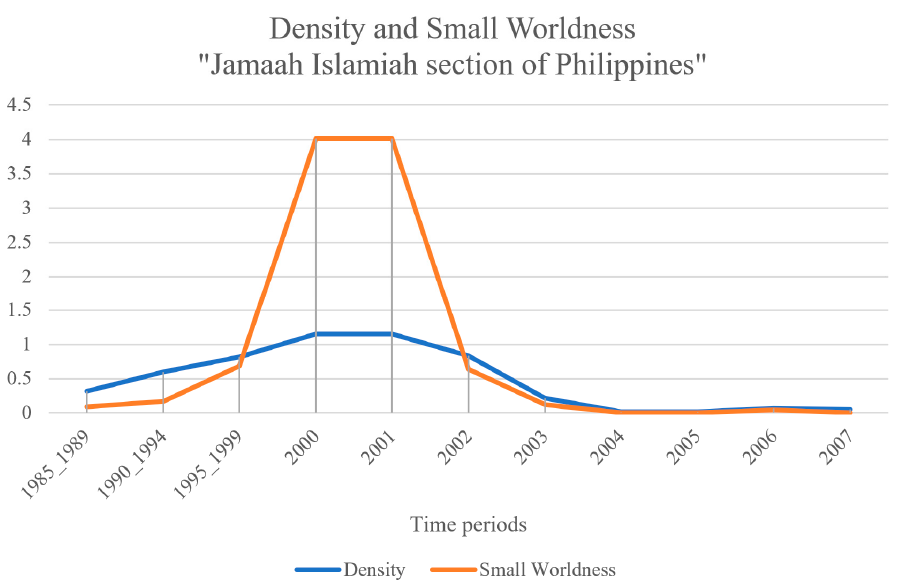
Figure 8. Temporal development of density and small worldness for the “Jamaah Islamiah section of Philippines”. Both indices increase till 2000, reach a plateau during 2000 and 2001 and then fall rapidly till 2002. Afterwards, both indices decrease slowly till 2003 and then take values very close to zero. The observed temporal development is more pronounced for small worldness by an order of magnitude. More specifically, the small worlness increase is about 450%, while the density increase is about 50%.